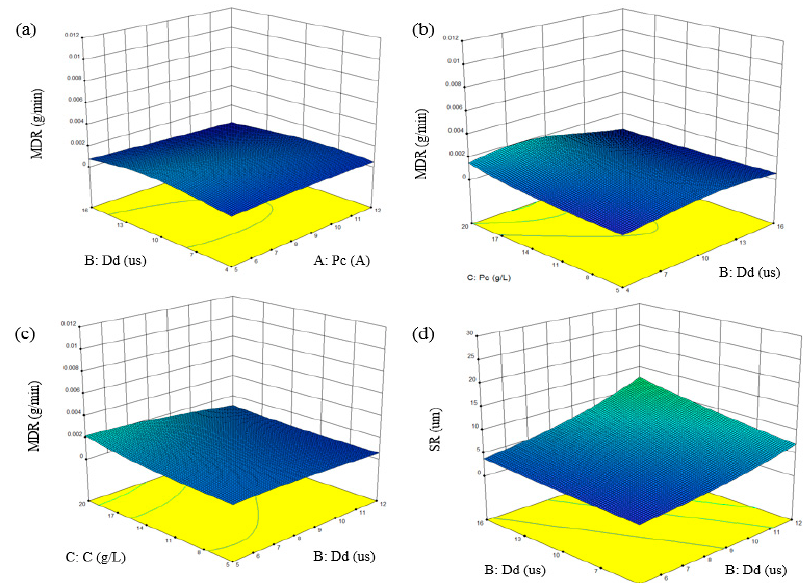
Figure 10. 3D surface plots for HDR and SR.